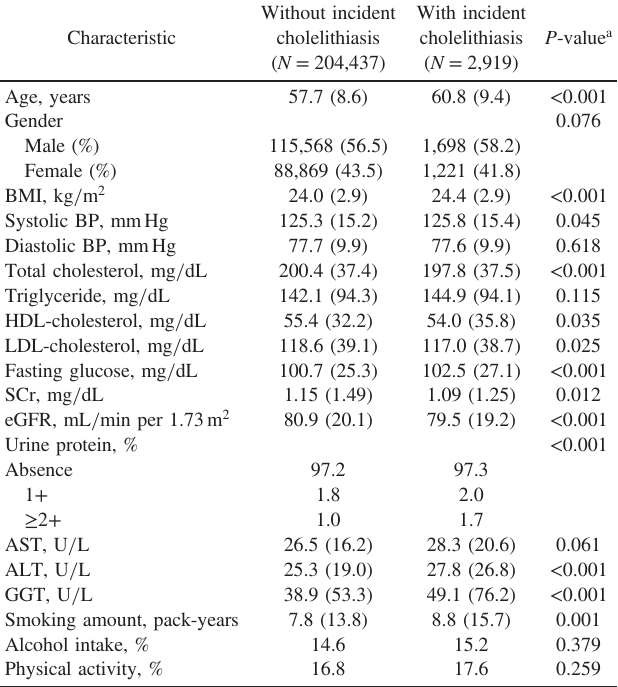
Table 2. Comparison between participants with and without incident cholelithiasis Without incident Characteristic cholelithiasis